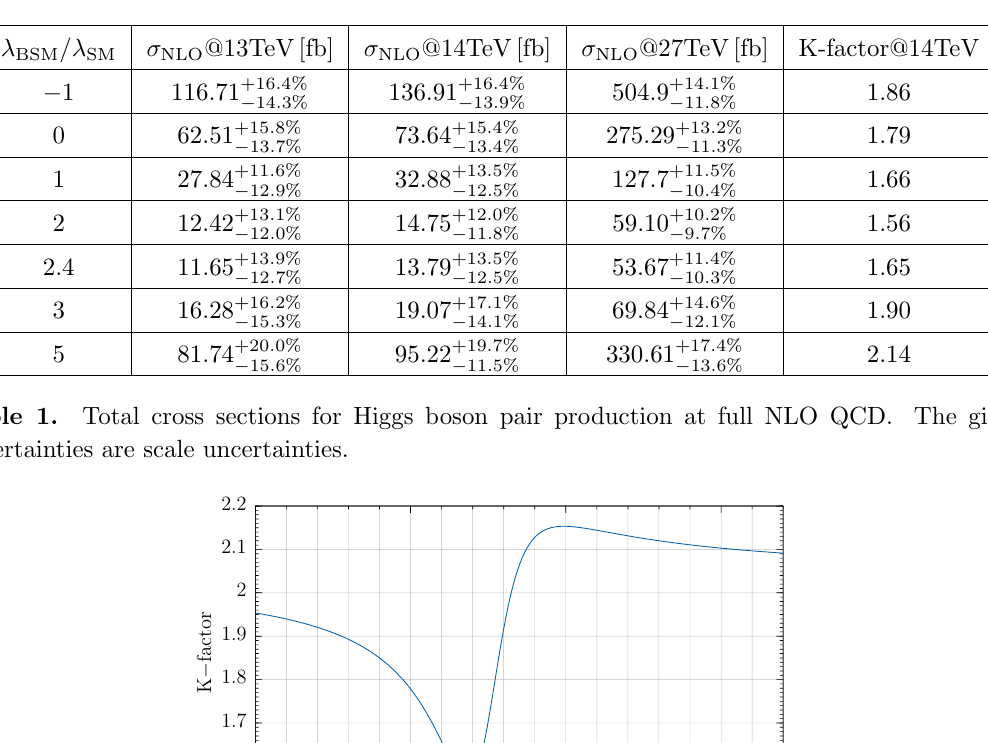
Figure 1. Variation of the NLO K-factor with the trilinear coupling at uncertainties are estimated by varying the factorisation/renormalisation scales (cid:22) scale variation bands represent scale variations around the central scale (cid:22) (cid:22) = (cid:22) = c (cid:22) , where c 2 f 0 : 5 ; 1 ; 2 g 0 R F